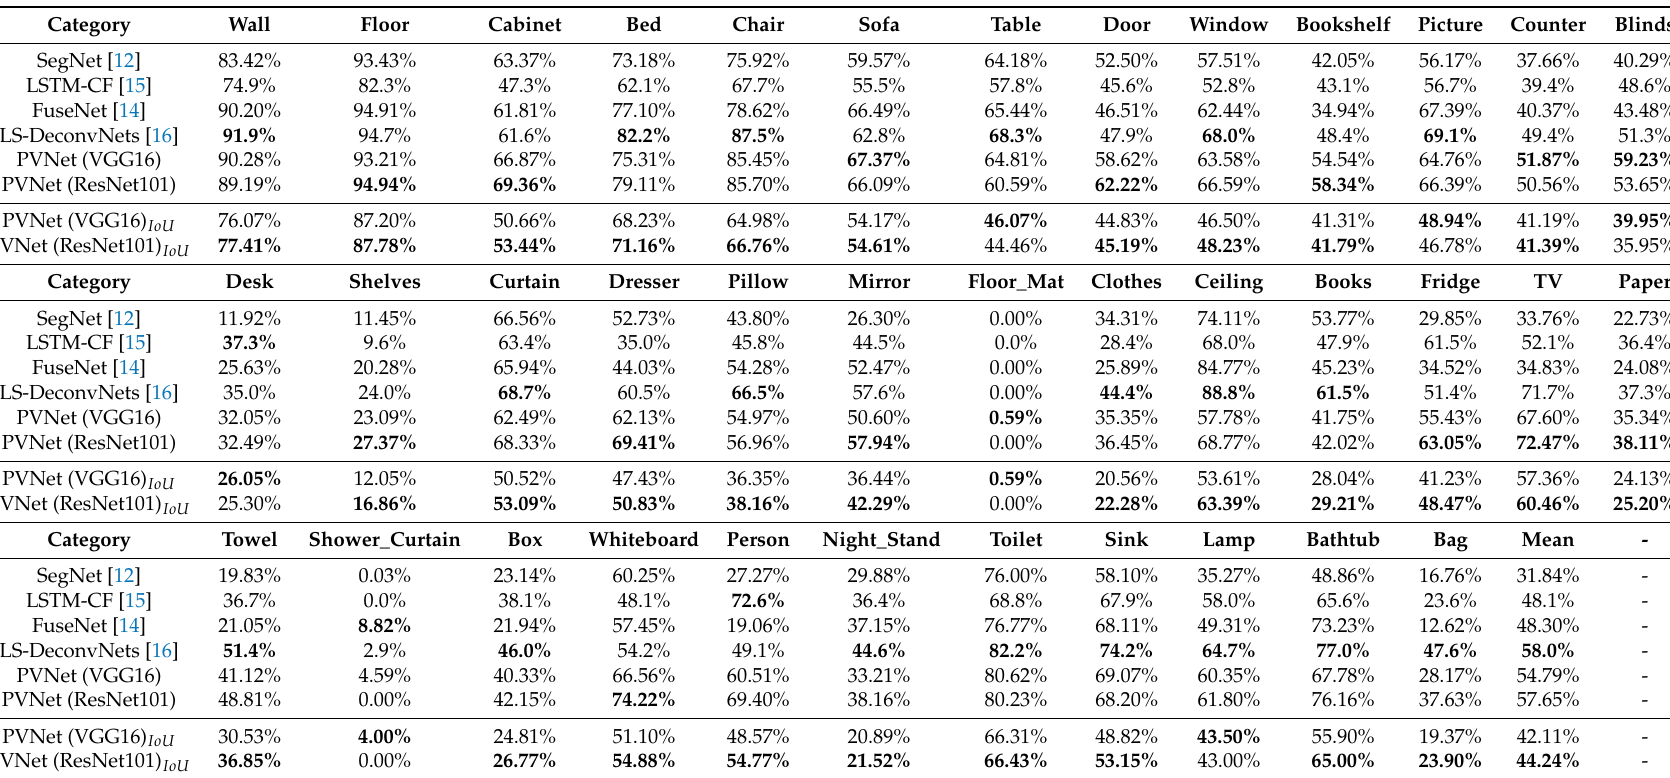
Table 3. Comparison of the class-wise accuracy on the SUN RGB-D dataset. Some of the methods in Table 1 do not provide the class-wise accuracy; hence, they are omitted here. The class-wise IoU of the Pixel-Voxel network (PVNet) is also provided. LS, locality-sensitive. The best performance among the compared methods is marked as